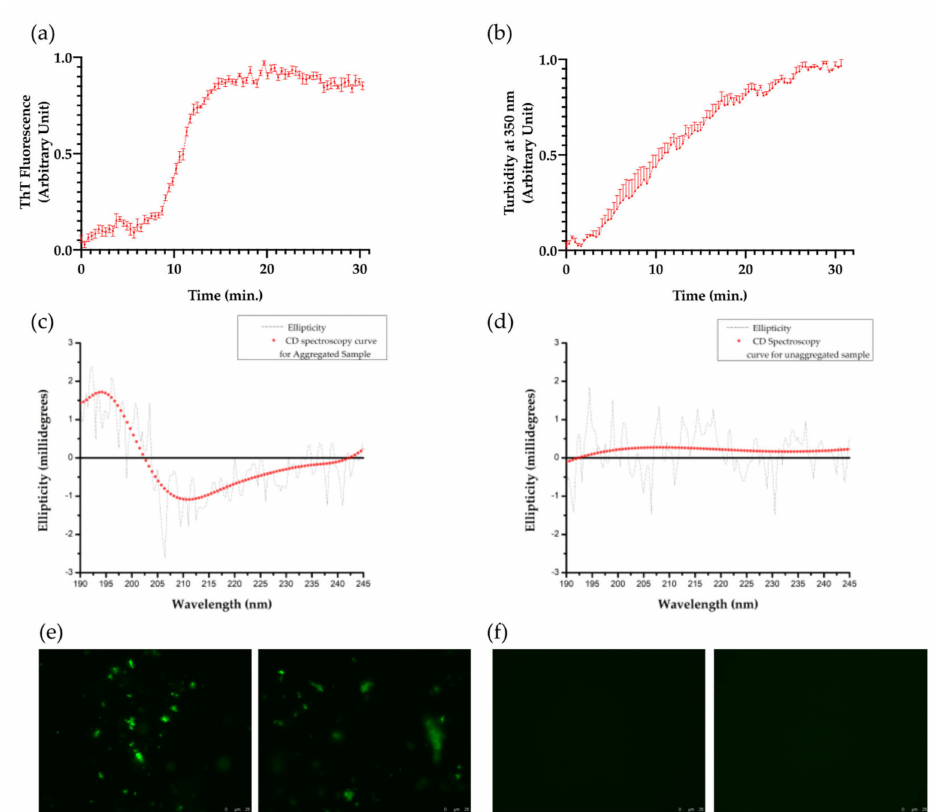
Figure A1. Formation of tau-PHF6 aggregates. ( a ) ThT fluorescence data depicts the aggregate formation of tau-PHF6 ( n = 4) over time. ( b ) Turbidity measurement assay: Absorbance at 350 nm depicting the formation of aggregated tau-PHF6 species over time. Error bars denote standard error (with n = 4). ( c , d ) CD spectroscopy curves for aggregated and unaggregated PHF6, respectively. ( e ) Fibrillization of aggregated PHF6 as observed by fluorescence microscopy (63X) (representative images from two different replicates). ( f ) Unaggregated PHF6, as observed by fluorescence microscopy (63X) (representative images from two different replicates).